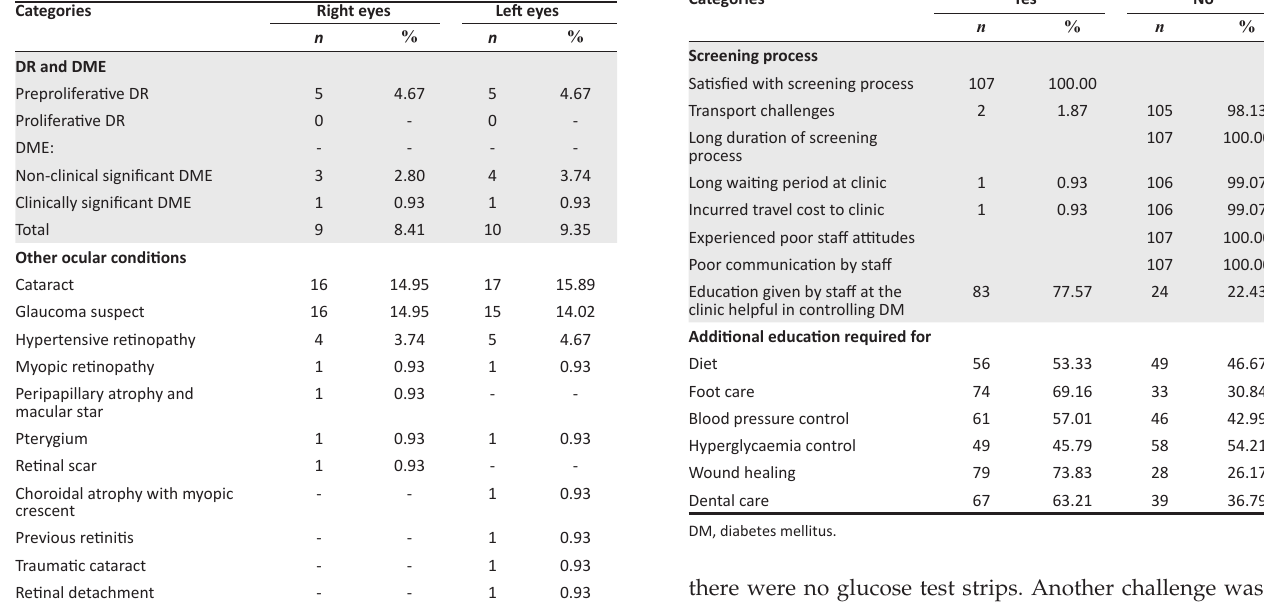
TABLE 5: Diabetic retinopathy and other ocular lesions in 107 patients with diabetes mellitus.